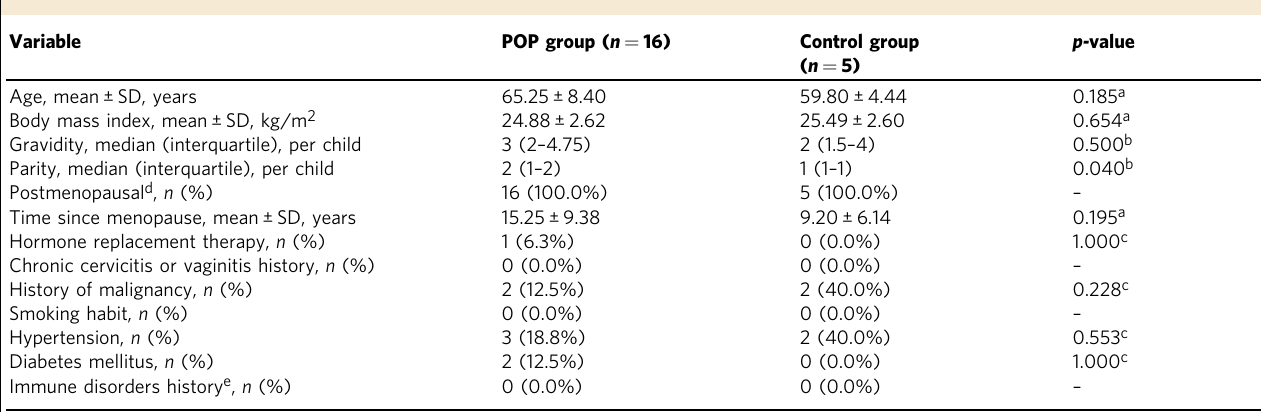
Table 1 Statistical analysis of clinical characteristics of